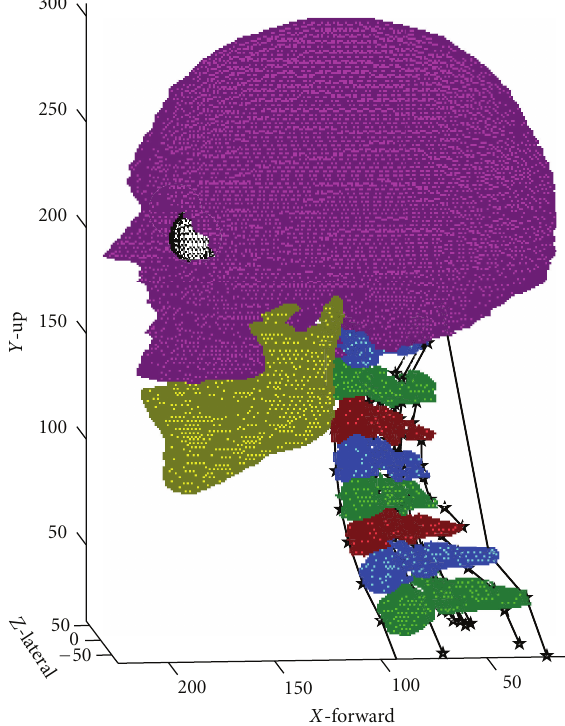
Figure 7: Head and neck complex with the ligaments considered in the